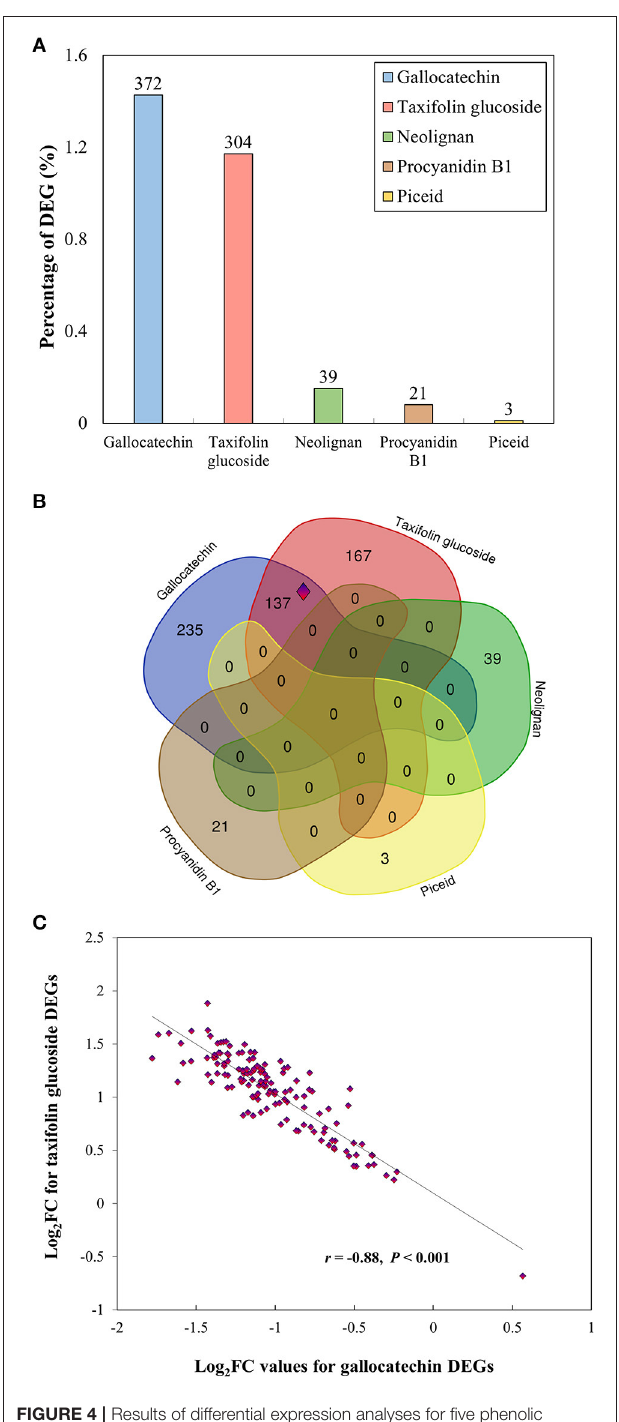
FIGURE 4 | Results of differential expression analyses for five phenolic compounds. (A) Proportion of differentially expressed genes (DEGs) among groups of individuals displaying contrasting phenotypes, for each metabolite. The proportion of DEGs was calculated as the number of DEGs divided by the total number of genes expressed. The number of DEGs is reported above the bars. (B) Venn diagrams showing the overlap among the 603 DEGs identified for all five metabolites. The set of 137 genes shared between gallocatechin and taxifolin glucoside (surrounded by a blue and red diamond) is further